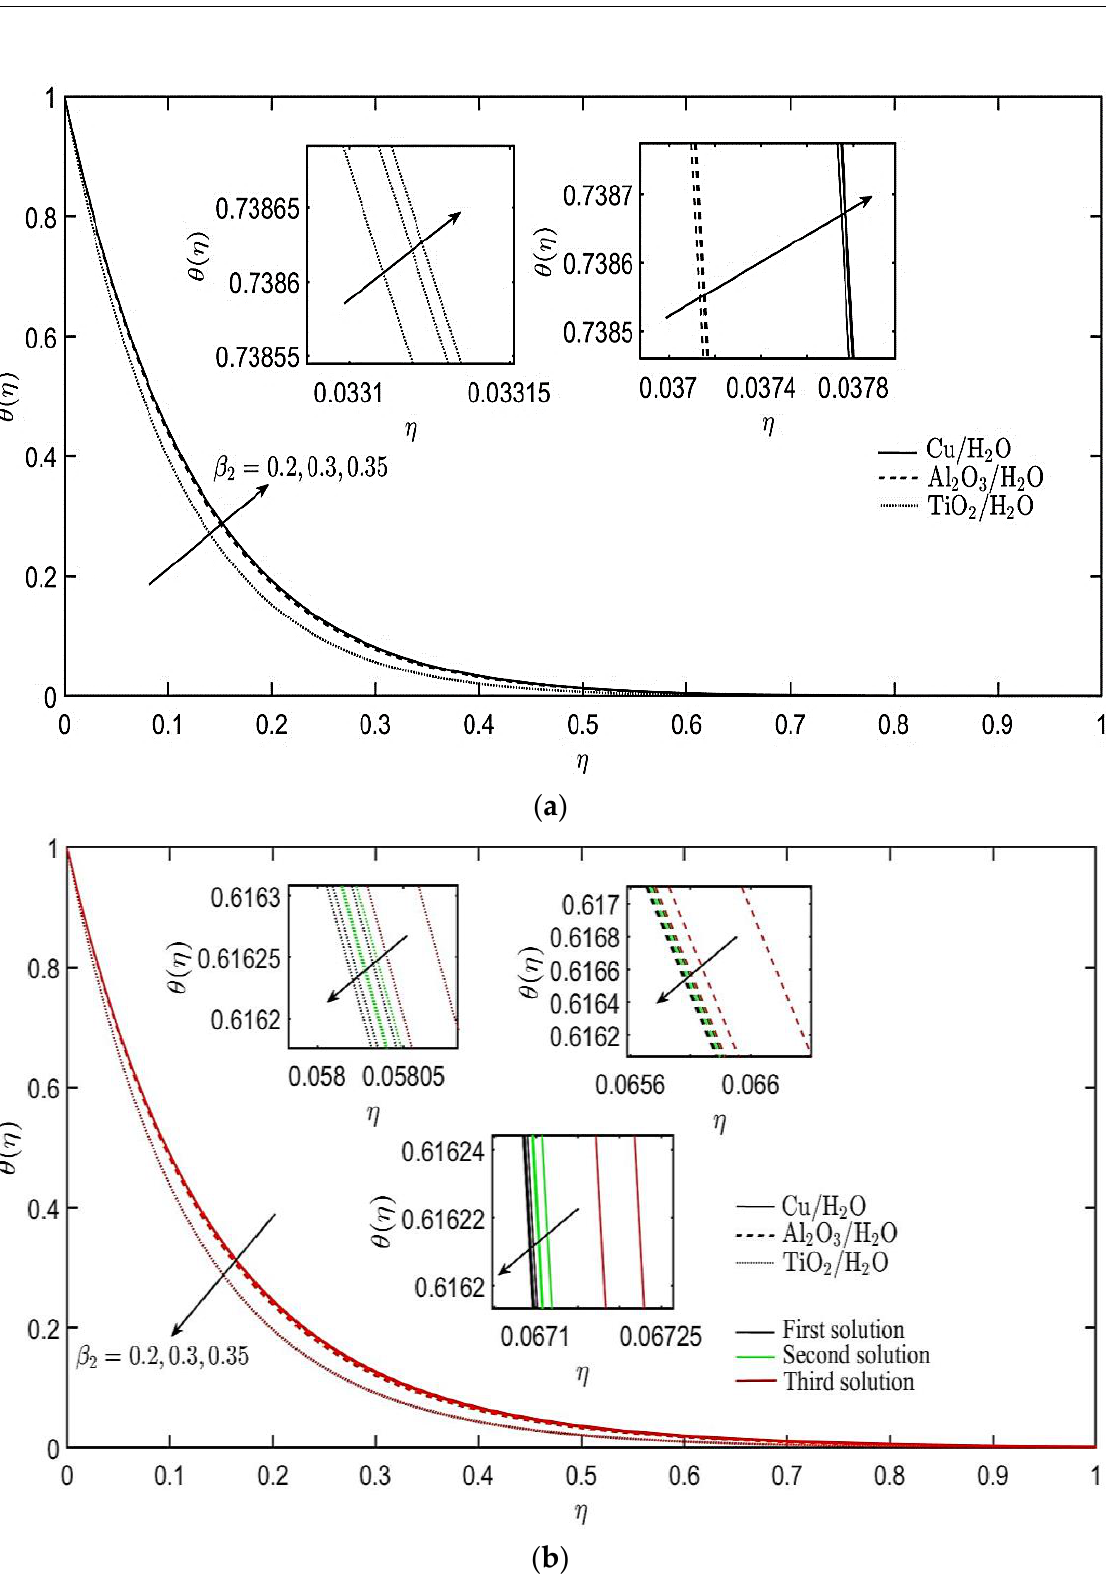
Figure 10. Effect of Burgers’ fluid parameter on temperature profiles for: ( a ) Stretching case; ( b ) Shrinking case.